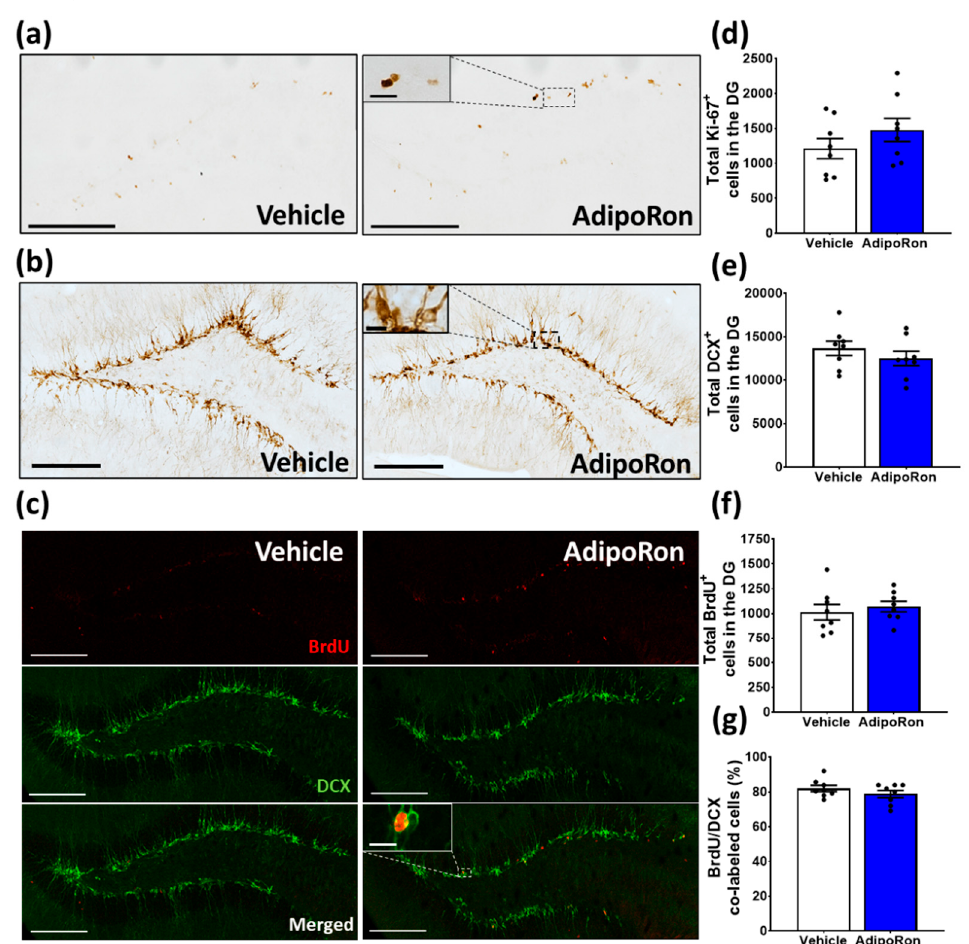
Figure 3. AdipoRon treatment did not change adult hippocampal neurogenesis. Representative images of ( a ) Ki-67+ cells, ( b ) DCX+ cells, and ( c ) BrdU/DCX co-labeled cells in the DG of vehicle- and AdipoRon-treated mice (scale bars, 200 μ m in 100x, 10 μ m in 400x). Treatment did not significantly change the total expression of ( d ) Ki-67, ( e ) DCX, and ( f ) BrdU-positive cells, nor did it affect ( g ) the percentage of BrdU/DCX co-labeled neurons in the DG. Student t-test. Data presented as mean ± SEM.